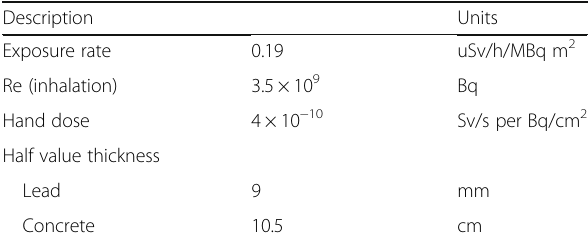
Table 3 Dosimetrical aspects of 89 Zr Description